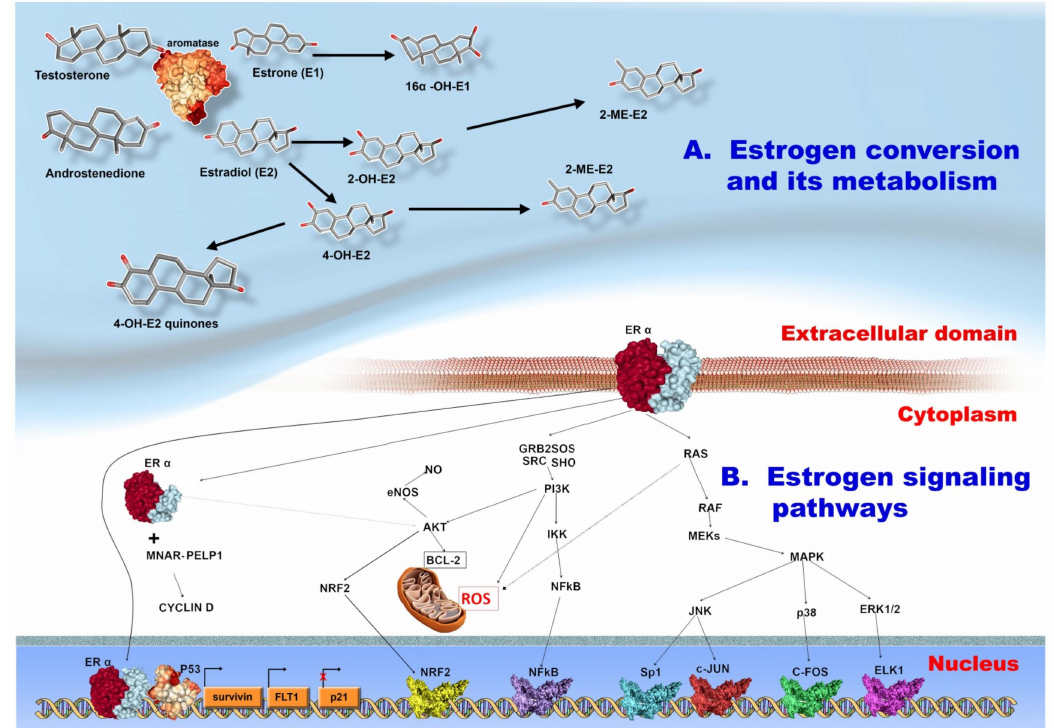
Figure 2. ( A ) Estrogen biogenesis, and its metabolism. The male hormones, androstenedione, and testosterone are converted by aromatase to estrone (E1) and estradiol (E2). Estrone is converted to 16 α -hidroxy-estrone. The estradiol is converted to 2-hidroxy-estradiol (2-OH-E2) or to 4-hydroxy-estradiol (4-OH-E2). The 2-OH-E2 can be further metabolized to 2-methyl-estradiol. The 4-OH-E3 is also converted to 4-methyl-estradiol (4-ME-E2). The 4-OH-E2 can also interact with quinone, giving rise to the 4-hidroxy-quinones. ( B ) The signaling pathways initiated by estrogen interaction with its receptor. The ER α interaction with estrogen leads to the activation of several pathways. The RAS-RAF-MEK-MAPK pathway activates: JNK, p38, and ERK1 / 2 pathways. The JNK activates the Sp1, and c-JUN transcription factors. P38 leads to the activation of c-FOS and ERK1 / 2 to activation of ELK1. The estrogen receptor also interacts with GRB2 / SOS / SRC / SHO, leading to the activation of PI3K-IKK, and the NF κ B transcription factor. The PI3K activates AKT leading to the activation of the anti-apoptotic factor BCL-2, and the production of nitric oxide. The ER α can translocate to the cytoplasm or to the nucleus. In the cytoplasm, it interacts with MNAR-PELP1, and stimulates the activation of cyclin D. In the nucleus, ER α interacts with p53 and the DNA, leading to the up-regulation of survivin gene, Fms related tyrosine kinase 1- FLT1 , and the down-regulation of p21 . The 3D structure of proteins was taken from the RCSB-PDB database (https: // www.rcsb.org /